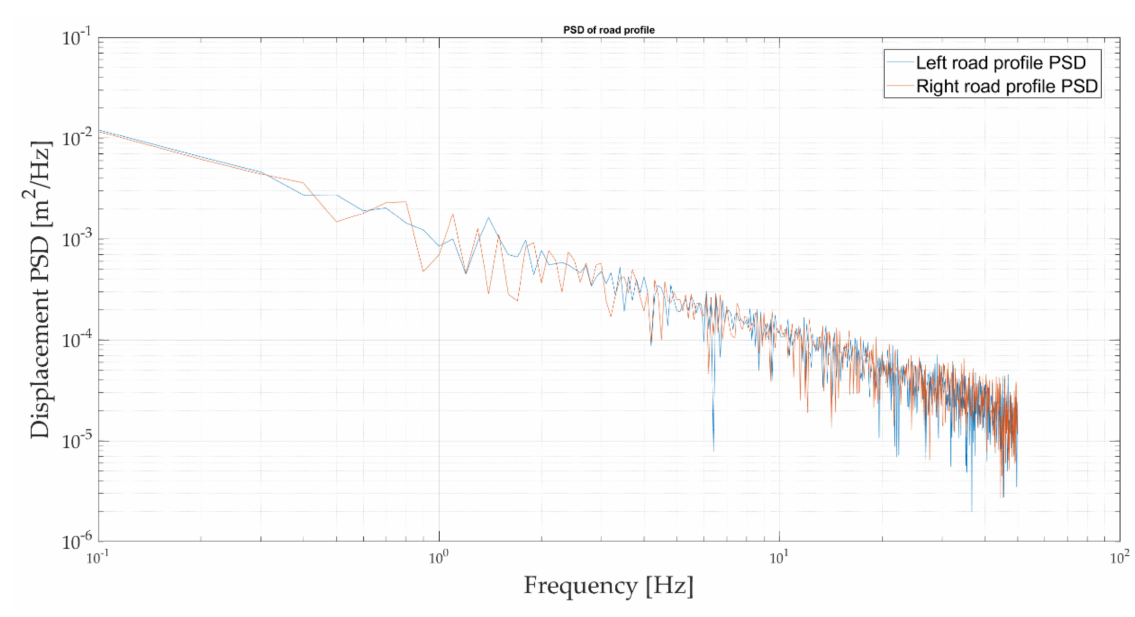
Figure 10. Road profile